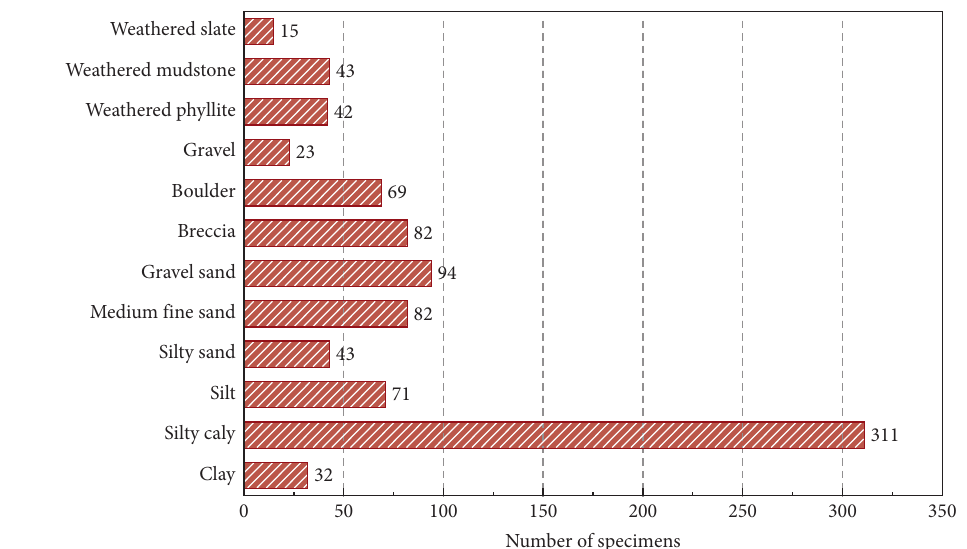
Figure 2: Statistic numbers of test samples for certain soil